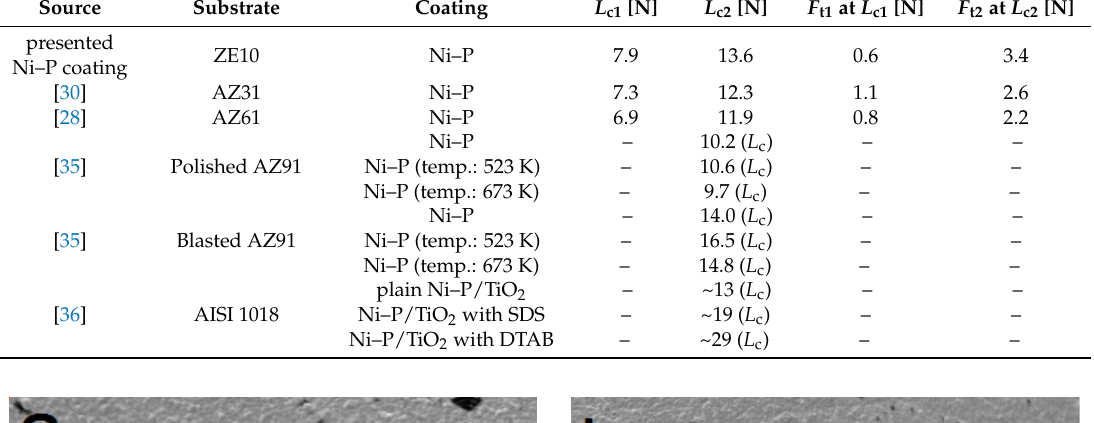
Table 2. Values of critical normal forces and friction forces of Ni–P coating deposited on the ZE10 magnesium alloy and, for comparison, values found in other studies.